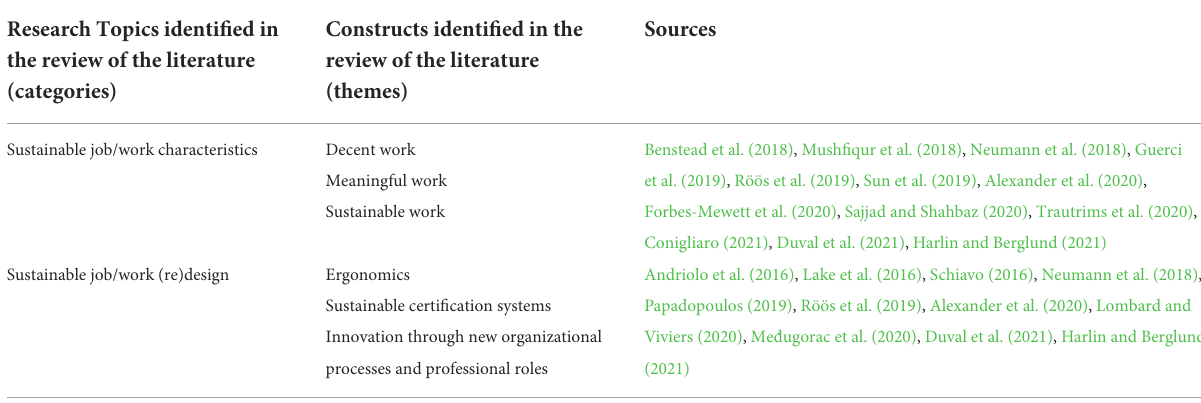
TABLE 2 Job/work-focused Research Topics and